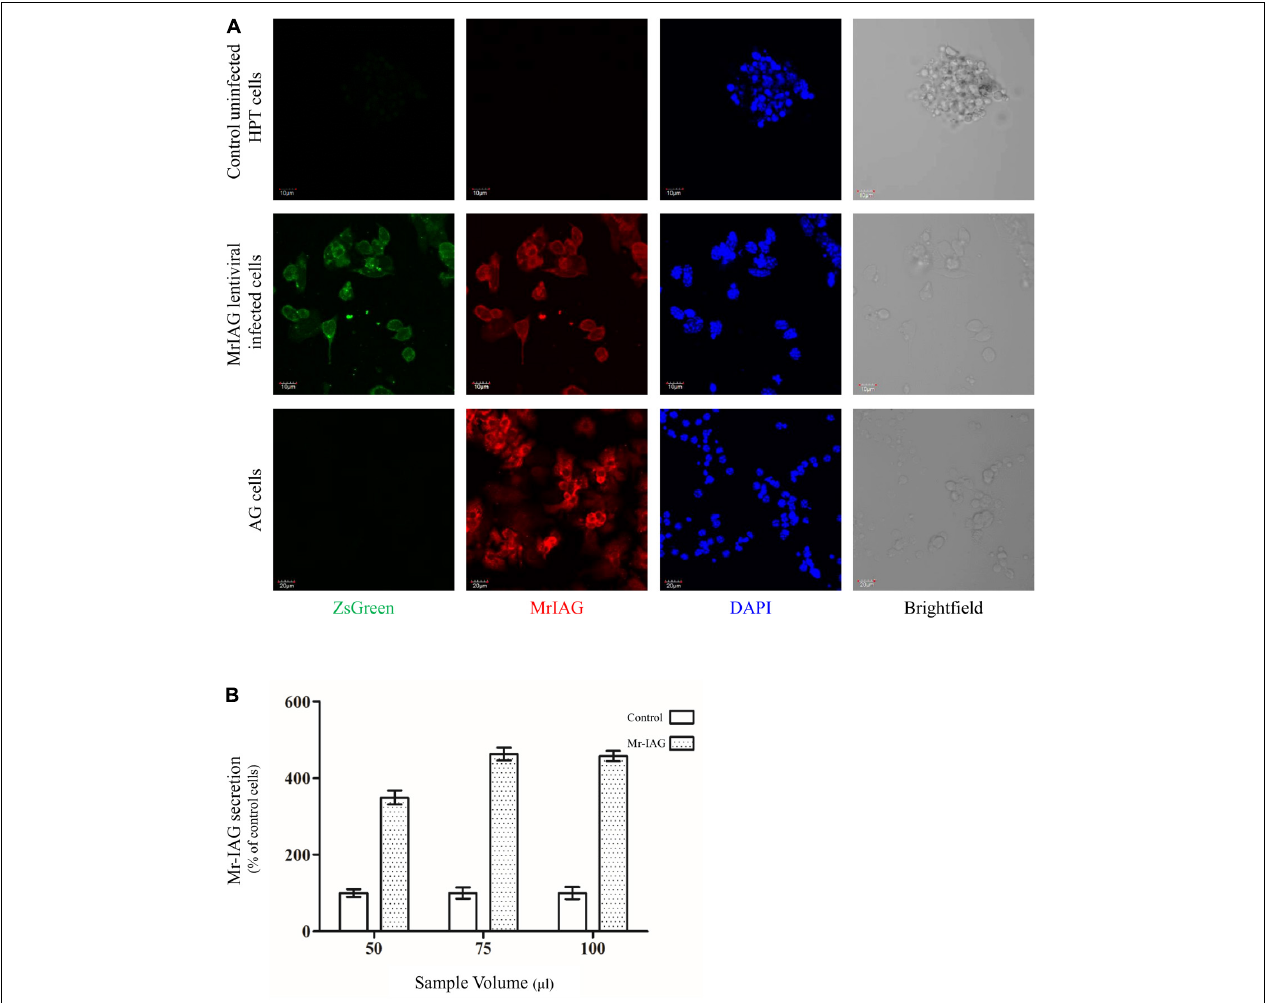
FIGURE 8 | Mr-IAG hormone synthesis and secretion by an M. rosenbergii hematopoietic primary cell culture following transduction with the Mr-IAG lentivirus. (A) Representative images of control uninfected M. rosenbergii primary cells, Mr-IAG-infected cells, and AG primary cells, which served as the positive control. Cells were immunostained with a specific antibody against Mr-IAG and examined using confocal microscopy with the appropriate lasers (488 nm for ZsGreen and red signal at 546 nm for secondary donkey anti-rabbit IgG Alexa Fluor) for Mr-IAG detection. Nucleic acid staining was performed with DAPI. Scale bar = 10 or 20 µ m, as indicated. (B) Relative quantitative secretion of Mr-IAG into the culture medium by Mr-IAG lentivirus-infected M. rosenbergii cells. Four days following transduction of M. rosenbergii cells with Mr-IAG lentiviruses, Mr-IAG protein was detected using sandwich ELISA in different volumes of cell culture medium (50, 75, and 100 µ l) from Mr-IAG infected cells (spotted bars) or uninfected cells (clear bars). Y-axis represents the percentage of Mr-IAG hormone secreted relative to control in each volume.